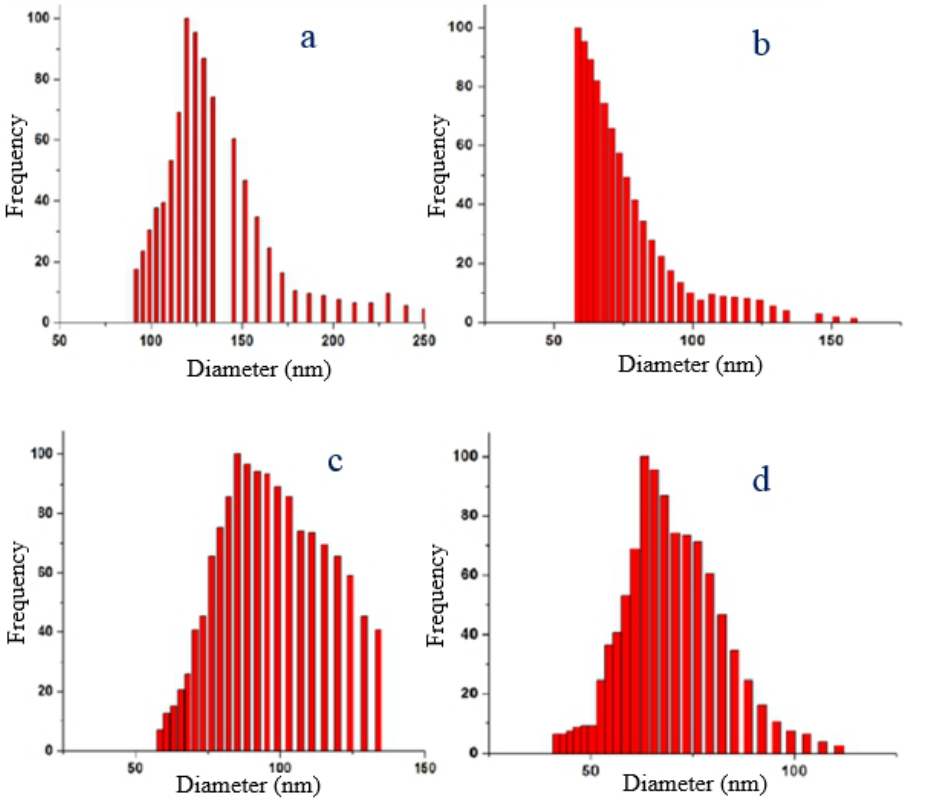
Fig. 6. DLS of nanoparticles a) ZnO b) WO-ZnO 0.5% c) WO-ZnO 1% d) WO-ZnO 2%